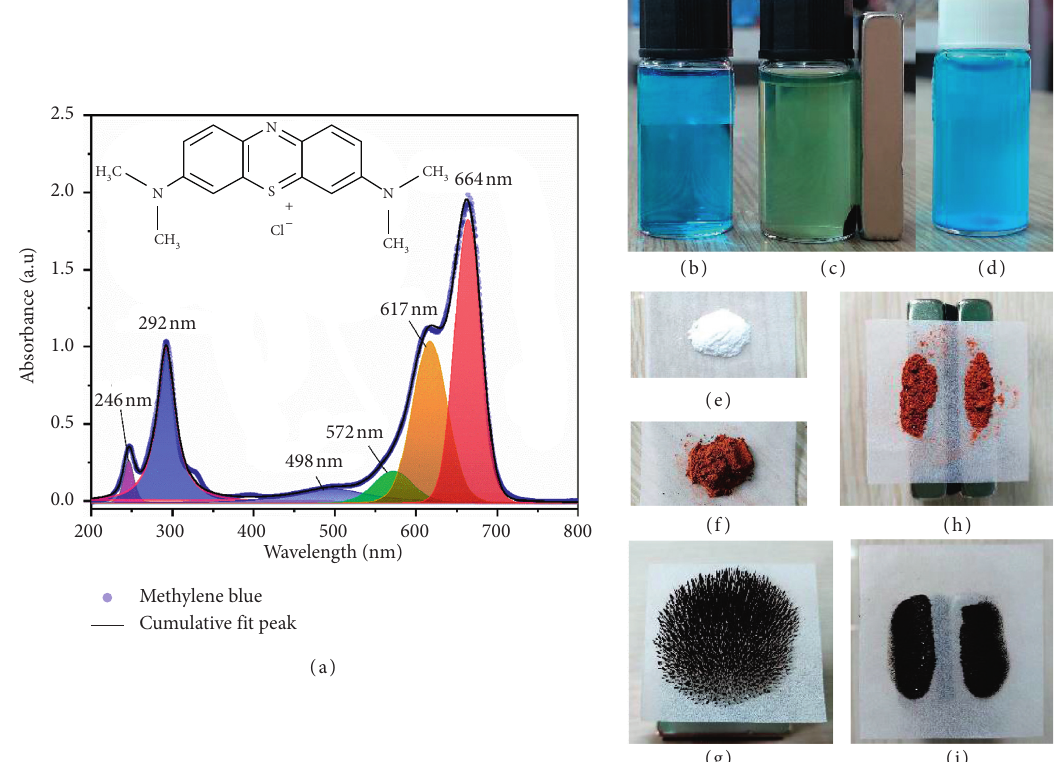
Figure 1: UV-VIS absorbance spectrum of the as-prepared methylene blue solution with characteristic peaks fitting results (a); photograph images of (b) initial MB solution; MB solution treated with the as-synthesized Fe 3 O 4 /ZA nanocomposite (c) and with zeolite NaA (d); photograph images of (e) zeolite NaA; Fe 3 O 4 /ZA nanocomposite (without applied magnetic field) (f); Fe 3 O 4 NP (g, i); Fe 3 O 4 /ZA nanocomposite and samples (under applied magnetic field)